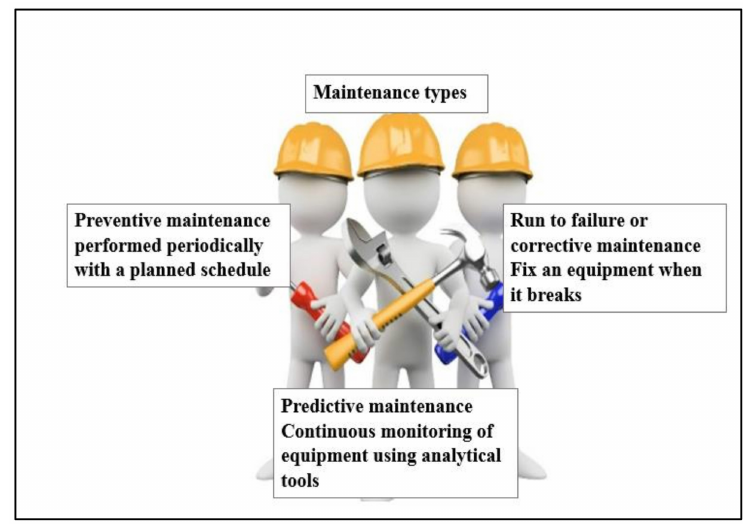
Figure 1. Maintenance types.